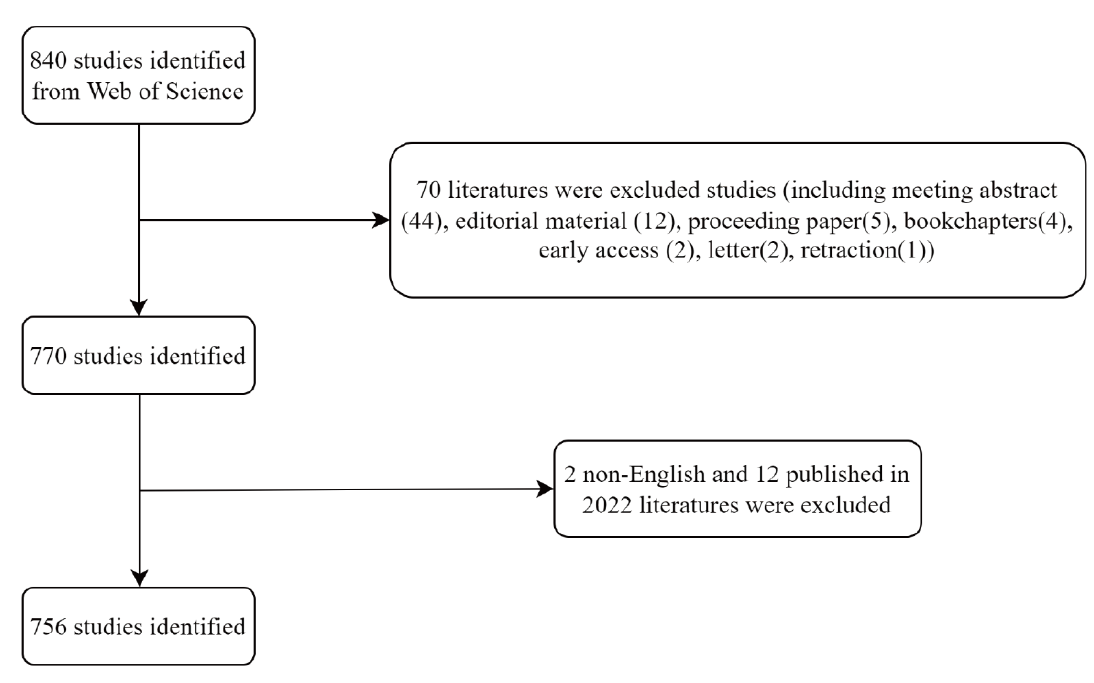
Figure 1. Flowchart of the screening process.